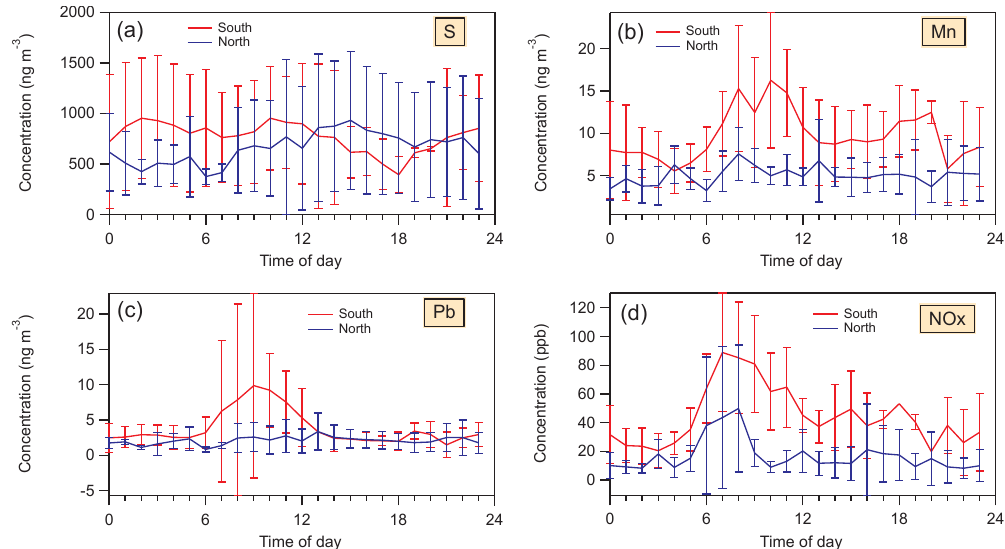
Figure 8. Mean diurnal variations of (a) S, (b) Mn, (c) Pb, and (d) NO x for the non-fireworks period stratified for south and north wind directions. Error bars denote ± 1 standard deviation of the averaging period. Diurnal variations for the other elements are shown in Fig. S5.